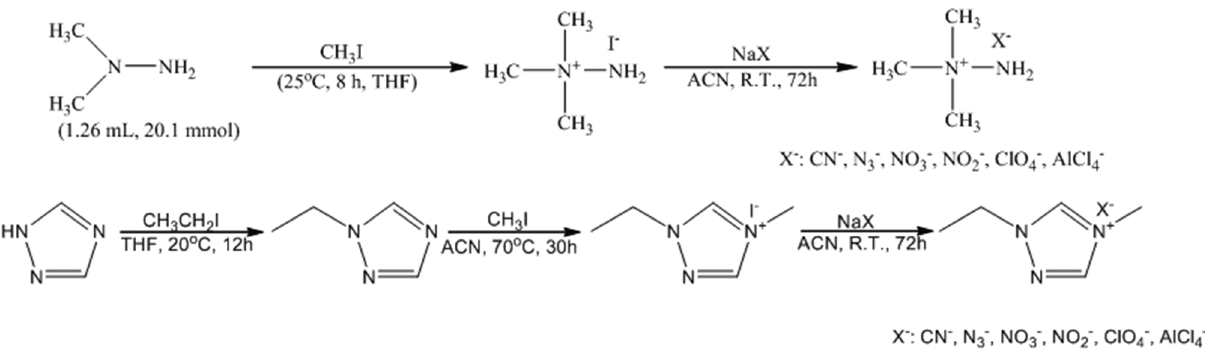
Figure 1. Schematic synthesis of N , N , N -trimethylhydraznium salts, [TMH] + [I] − , (upper) and 1-ethyl-4-methyl-1,2,4-triazole salts, [EMT] + [X] − , (down) by ion-exchange reaction